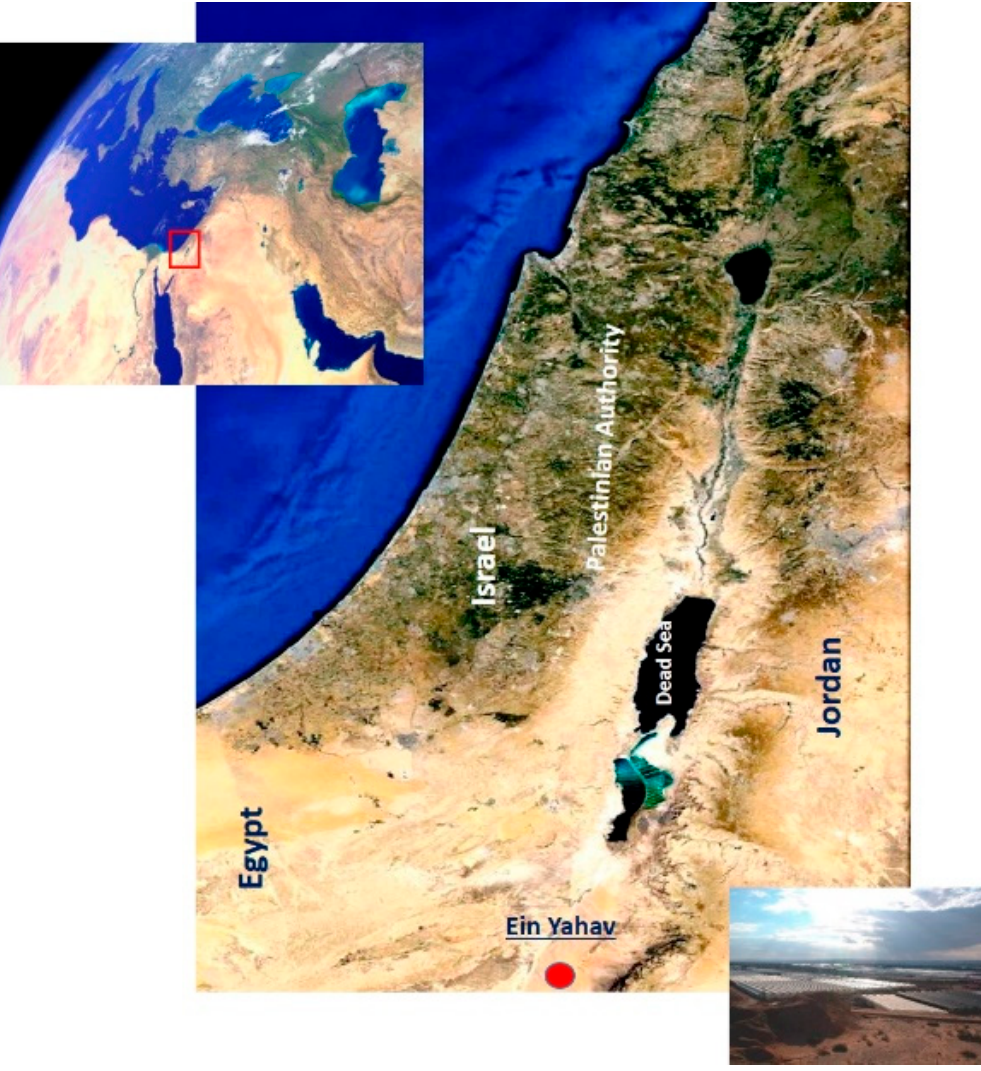
Figure 1. Location of the study site (Ein Yahav) in the Arava Valley (South Israel), and an aerial view of the agricultural area dominated by plastic greenhouses (image at the bottom of the figure). (Satellite images cropped from: https://www.google.com/) .